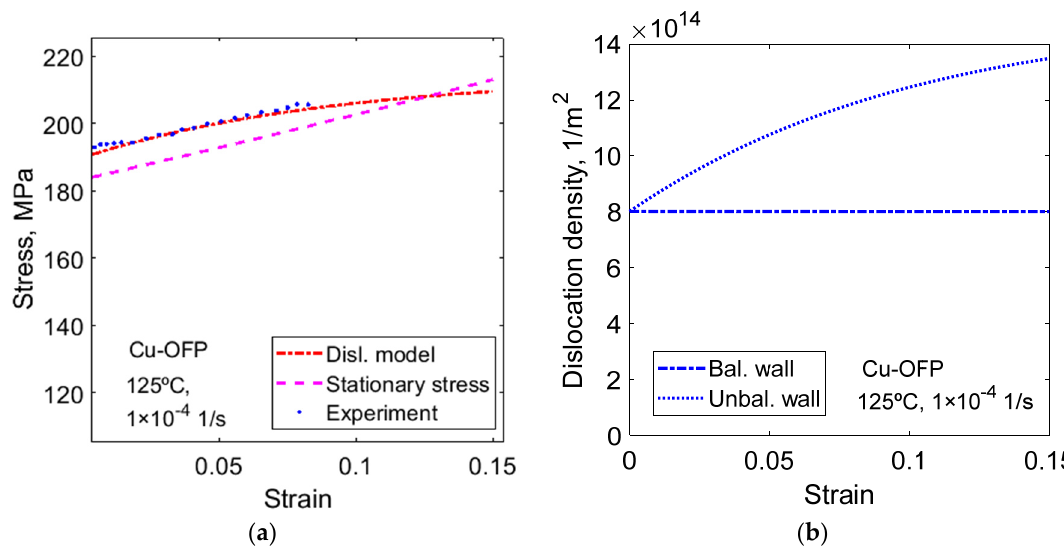
Figure 16. Stress strain curve for 15% cold worked Cu-OFP at 125 °C and 1 × 10 − 4 1/s; ( a ) the experimental curve is compared to modeling results with Equations (3), (23), and (24) for balanced and unbalanced boundary dislocations; ( b ) balanced and unbalanced boundary (wall) dislocation density. Experiments from [42]. Redrawn with permission from ref. [17]. Copyright 2022 Elsevier.